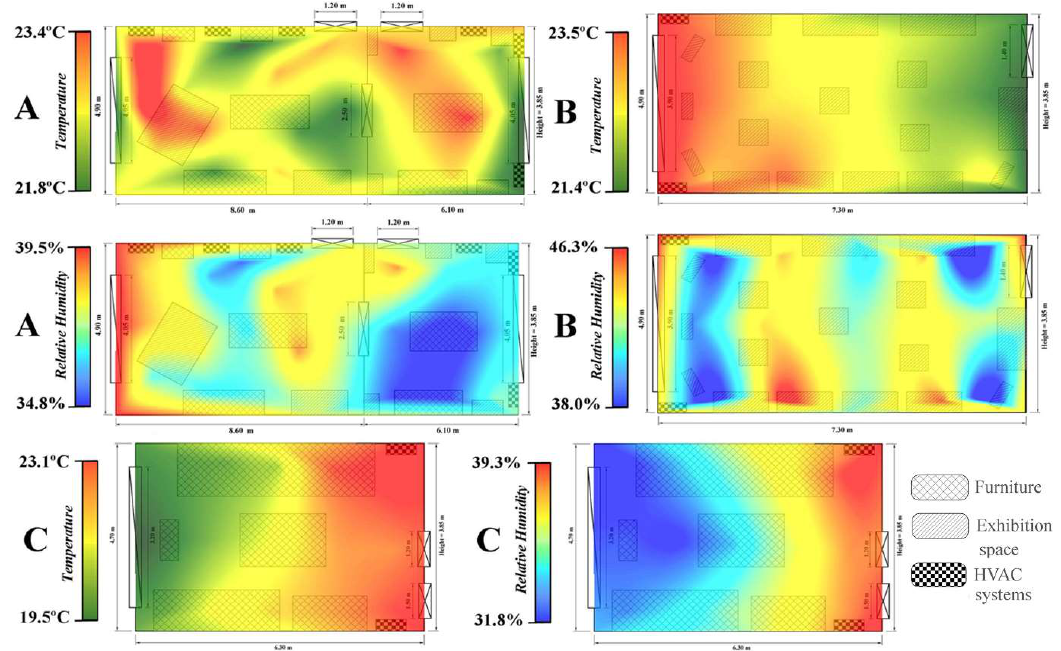
Figure 4. Spatial distribution of temperature and relative humidity within the three analyzed rooms of Darvas-La Roche House (( A )—The great hall–1st floor; ( B )—Exhibition hall–Ground floor; ( C )—Bedroom–1st floor).